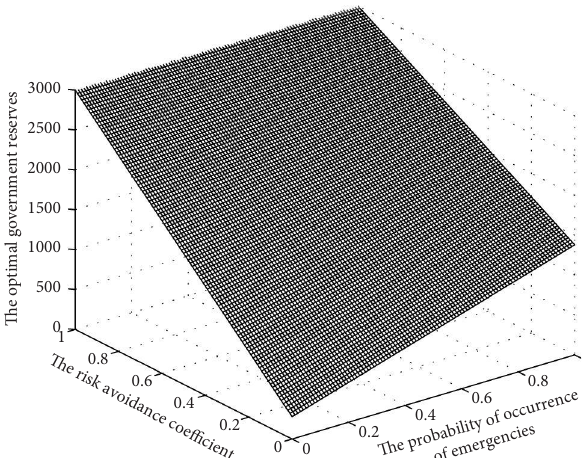
Figure 4: Te infuence of the probability of occurrence of emergencies and risk avoidance coefcient on optimal government